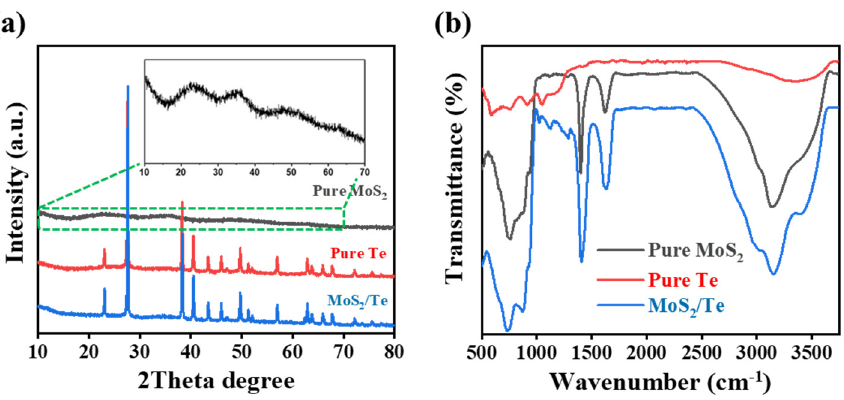
Figure 3. XRD and FTIR analyses of samples: ( a ) XRD spectra and ( b ) FTIR spectra.